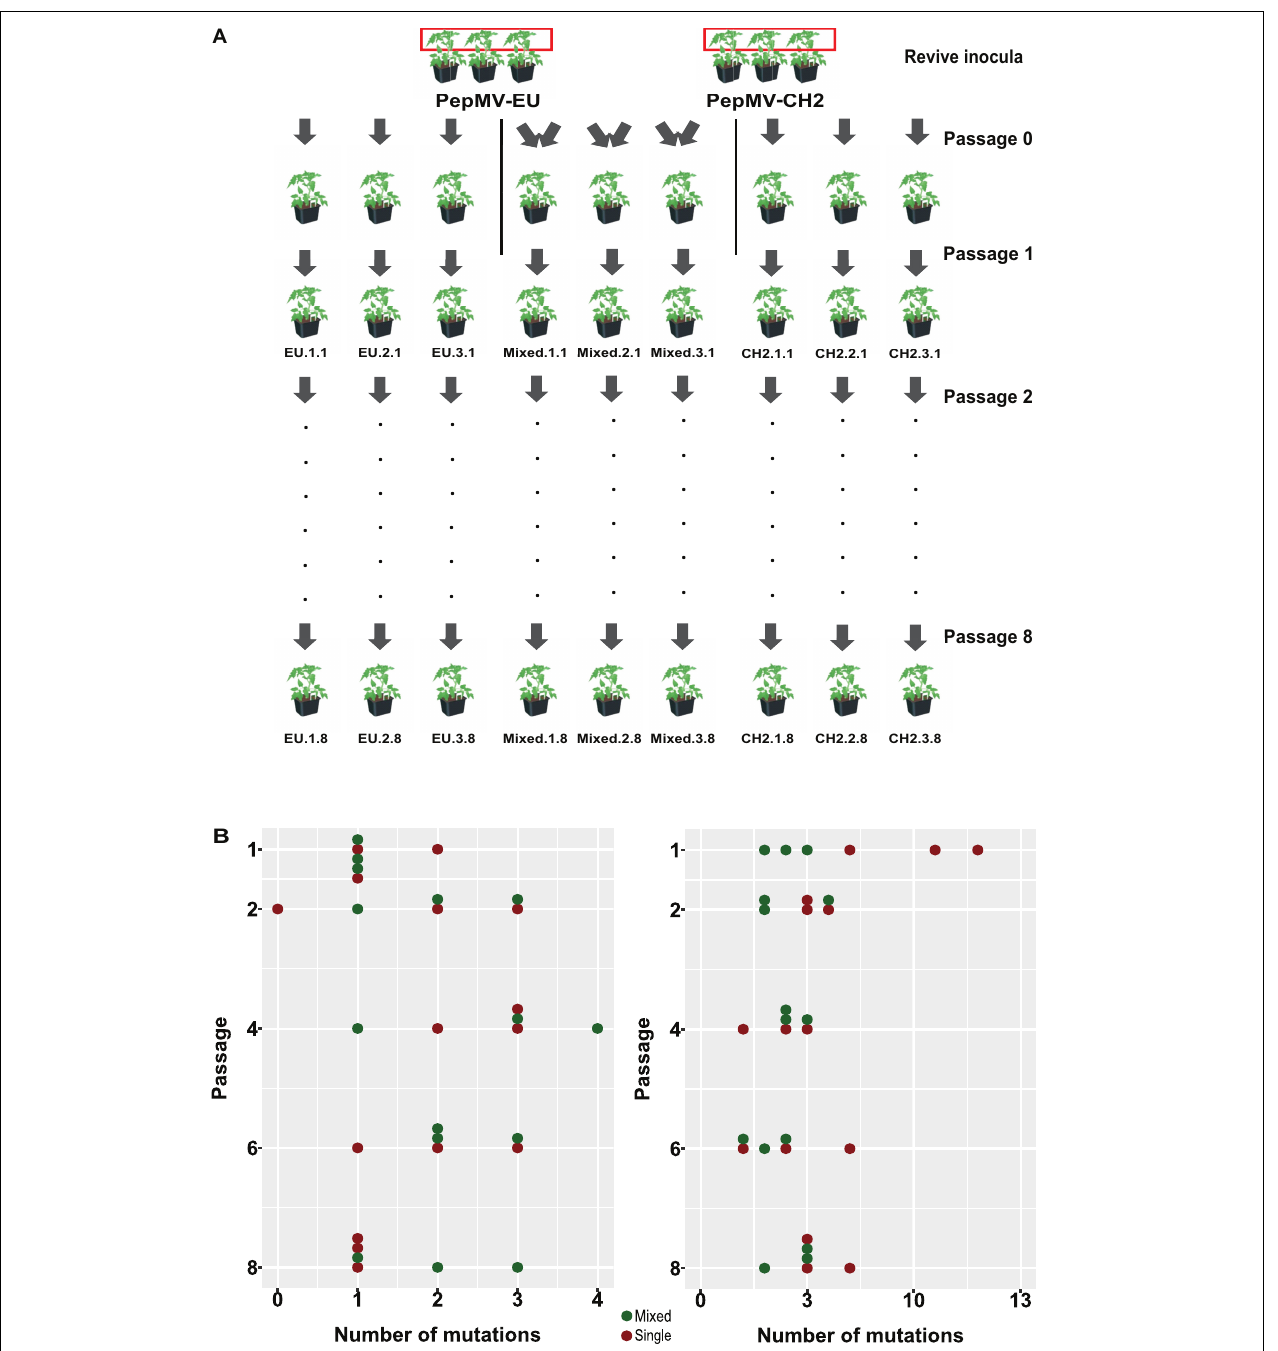
FIGURE 5 | Effect of mixed infections on PepMV genetic diversification. (A) Diagram modified from Agüero et al. (2018) illustrating the setting up of founder plants and the passaging of PepMV lineages. Viral populations were passaged every 10–12 days to healthy tomato plants (cv. Moneymaker). A region of 420 nucleotides from the PepMV RdRp was RT-PCR amplified and deep-sequenced for the three independent lineages of PepMV-EU, PepMV-CH2, and PepMV-EU + CH2 from passages 1, 2, 4, 6, and 8. (B) Scatter plots between the number of passage (1, 2, 4, 6, and 8) and number of mutations found in the PepMV-EU (top) and PepMV-CH2 (bottom) genomes. Each point represents a lineage; lineages from single or mixed infected plants are marked in red or green, respectively.